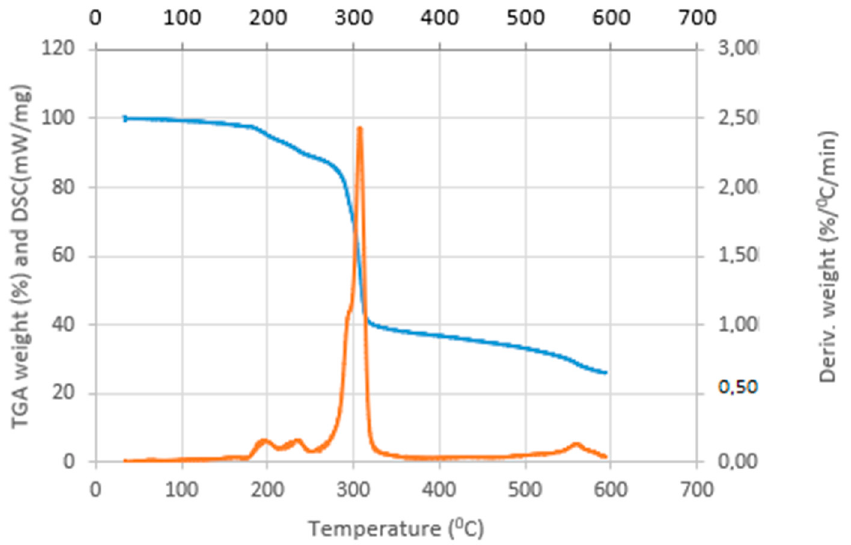
Figure 8. TGA and DSC plot of indium (III) N -methyl- N -phenyl dithiocarbamate complex. The blue color is the TGA plot while the orange color is the DSC plot.